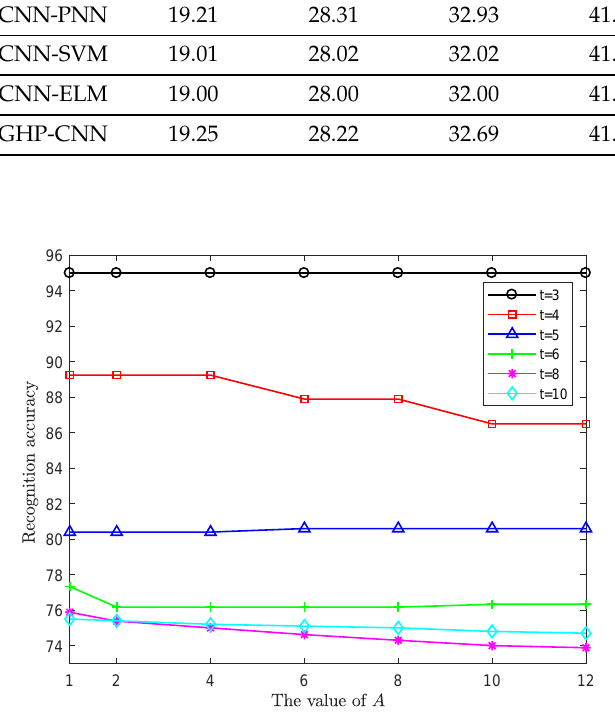
Figure 6. Effect of parameter A on classification accuracy of GHP-CNN.